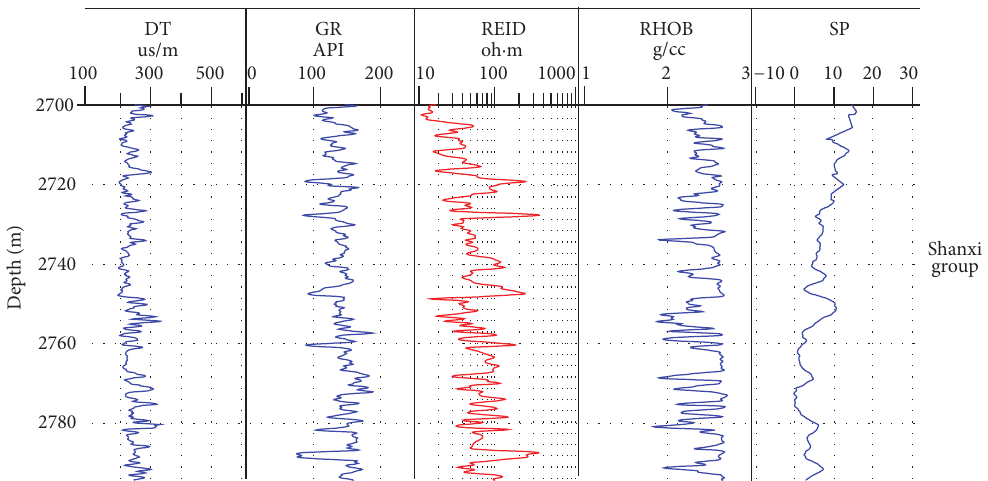
Figure 1: Logs showing of well YQ2 in the Shanxi group of Permian formation.